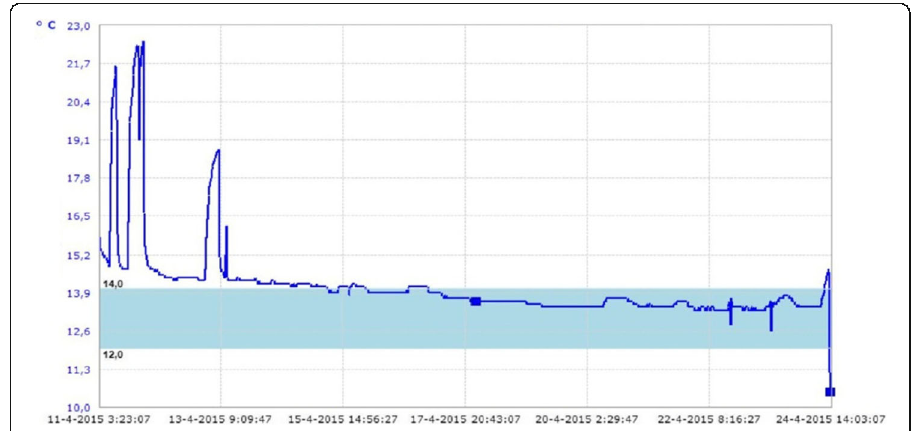
Fig. 1 Temperature development during transport of bananas (De Geest